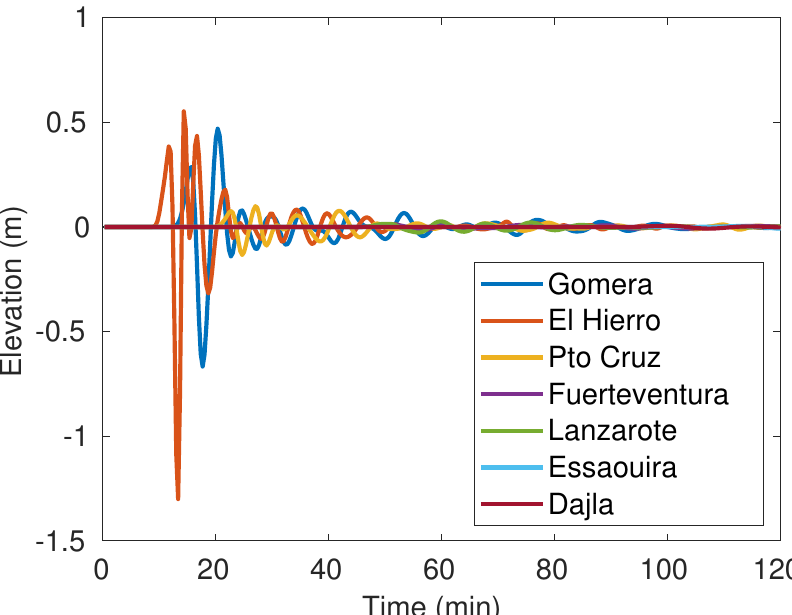
Figure 7. Time series of water surface elevations at selected points (Figure 1) for a 0.13 km 3 slide down the island slope.